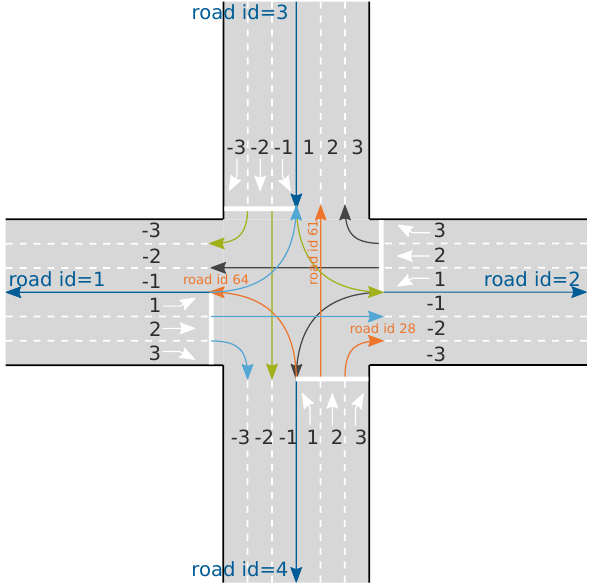
Figure 4. Road reference lines indicated as arrows with individual lanes indicated by lane ids from − 3 to 3 for a right-hand traffic